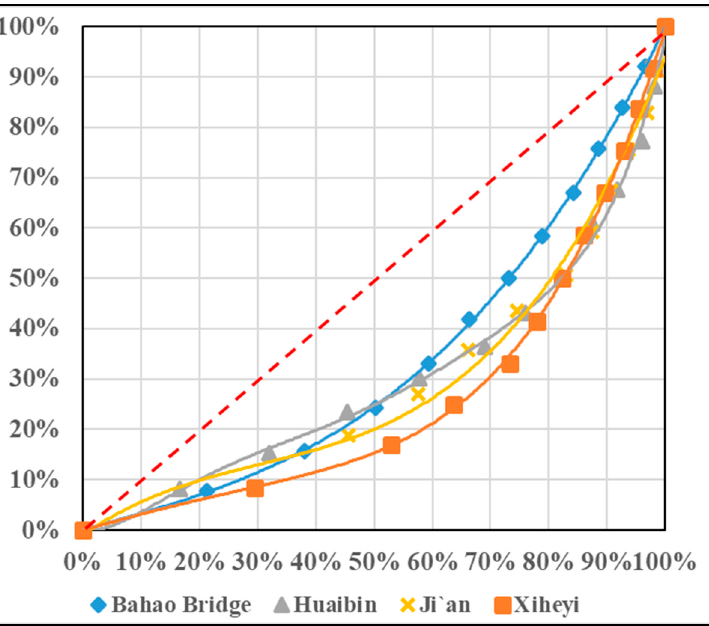
Figure 5. Comparison of the water quality–water quantity Gini coefficients.